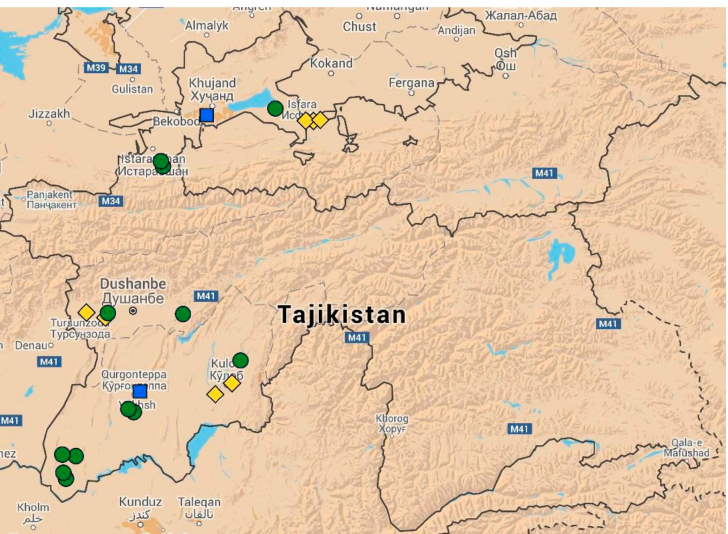
Figure 1. Map of Tajikistan (Google maps) showing the location of survey sites. Dehkan farms (DF, n = 13) are indicated by green circles, production cooperatives (PC, n = 6) by yellow diamonds and the Tajik Farming Institute (TFI, n = 2) by blue